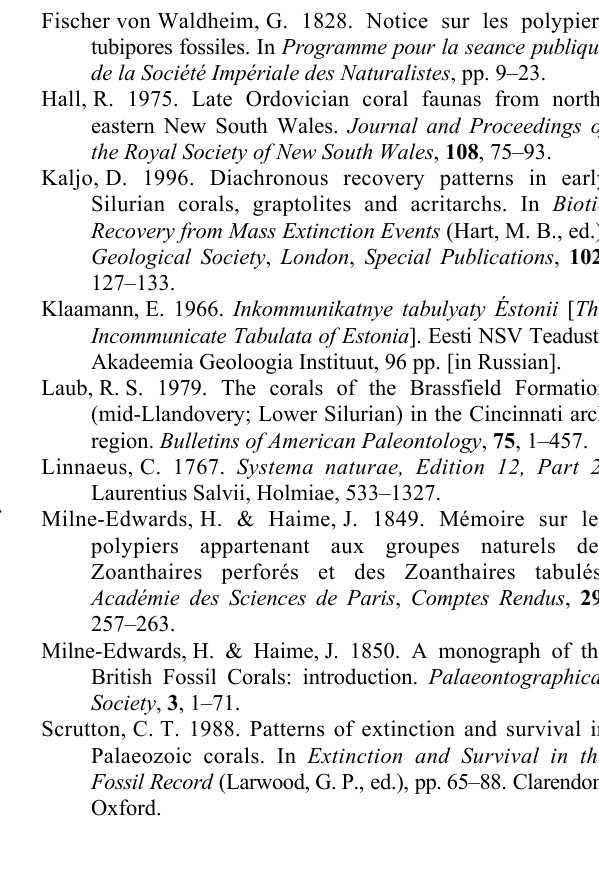
Table 2. Numerical data on Halysites gaojiangensis sp. nov. TaL = tabularium length (mm), TaW = tabularium width (mm), TaA = tabularium area (mm 2 ), TuL = tubule length (mm), TuW = tubule width (mm), WT = wall thickness (mm), LS = length of septa (mm), Ta5 = number of tabulae in 5 mm TaL TaW TaA TuL TuW WT